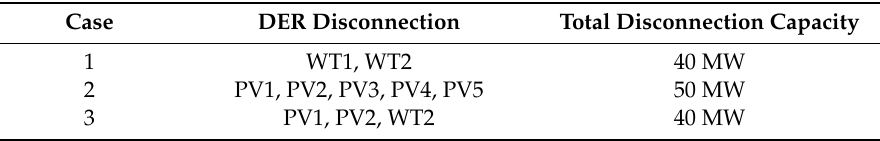
Table 3. DER disconnection cases for the “Y” substation.